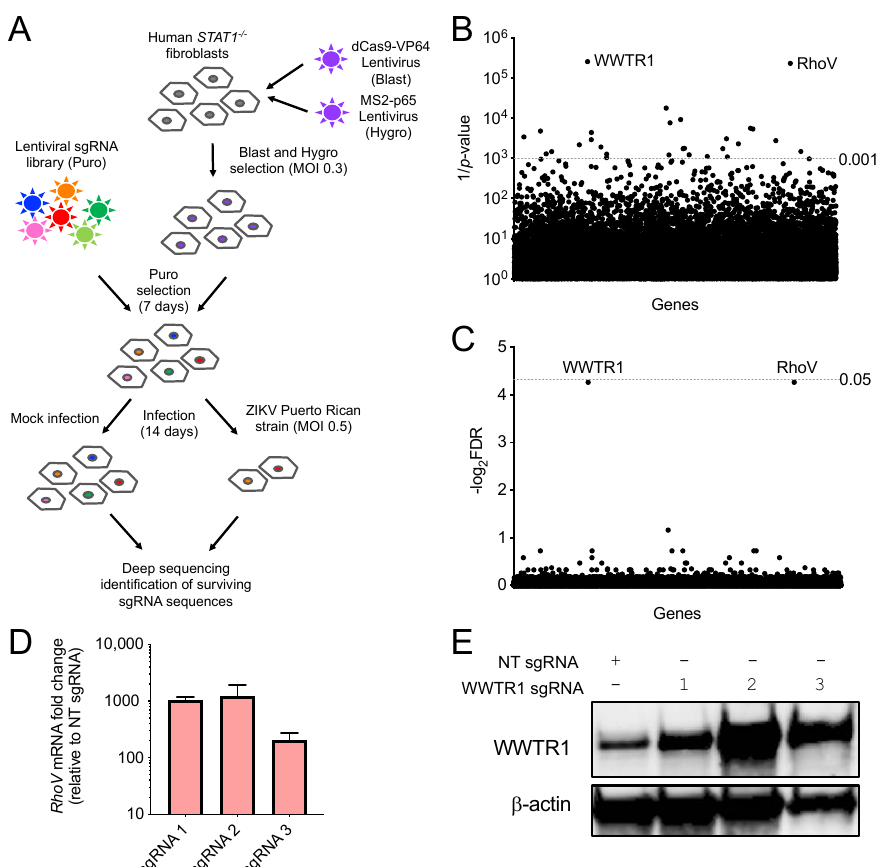
Figure 1. A genome-wide CRISPR activation ZIKV screen in cells defective in IFN signaling. ( A ) Schematic flow of the CRISPR activation screen setup and conditions. STAT1 − / − fibroblasts were transduced with lentiviruses carrying the SAM complex followed by the sgRNA library upregulating all known human gene isoforms. After antibiotic selection, these cells were challenged with ZIKV (strain: PRVABC59) at MOI of 0.5 PFU/cell and incubated for 14 days. Genomic DNA of mock- infected and ZIKV-infected cells was extracted, amplified, sequenced, and bioinformatically analyzed to determine potential antiviral and proviral candidate genes from the sgRNAs enriched or depleted in surviving cells, respectively. ( B , C ) Scatter plots showing negative selection of sgRNAs targeting the top candidate genes identified by MAGeCK VISPR, a quality control and analysis workflow for CRISPR screens, compared with other sgRNAs in the library after ZIKV infection ( p -value < 0.001 and false discovery rate (FDR) < 0.05). ( D ) RhoV mRNA levels were measured by RT-qPCR in STAT1 − / − fibroblasts transduced with lentiviruses carrying RhoV promoter targeting sgRNAs 1, 2, and 3. mRNA fold changes relative to the RhoV mRNA levels in NT sgRNA transduced STAT1 − / − fibroblasts are shown. The data are from one independent experiment performed in triplicate. ( E ) WWTR1 protein expression in STAT1 − / − fibroblasts transduced with lentiviruses carrying WWTR1 promoter targeting sgRNAs 1, 2, and 3 as well as NT sgRNA was determined by immunoblotting using WWTR1 antibody. β -actin serves as a loading control. The data are from one